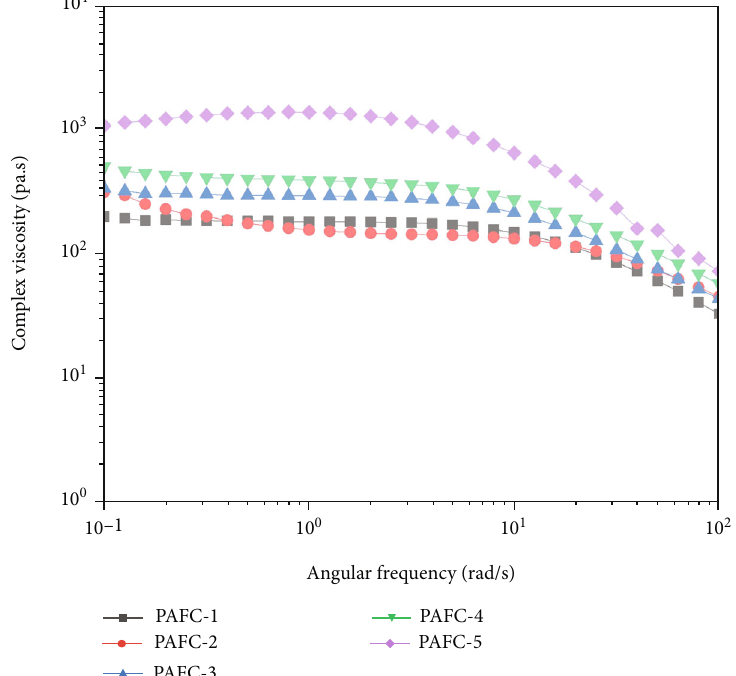
Figure 5: Changes of complex viscosity, η as function of angular frequency, ω for BHPF/ ð BPA + BHPF Þ molar ratio of PAFC at 320 °